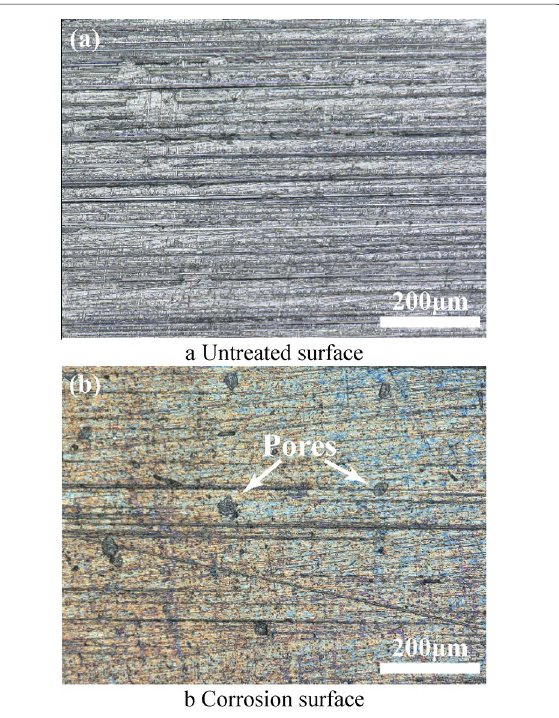
Figure 10 OM image of movable latch in Region